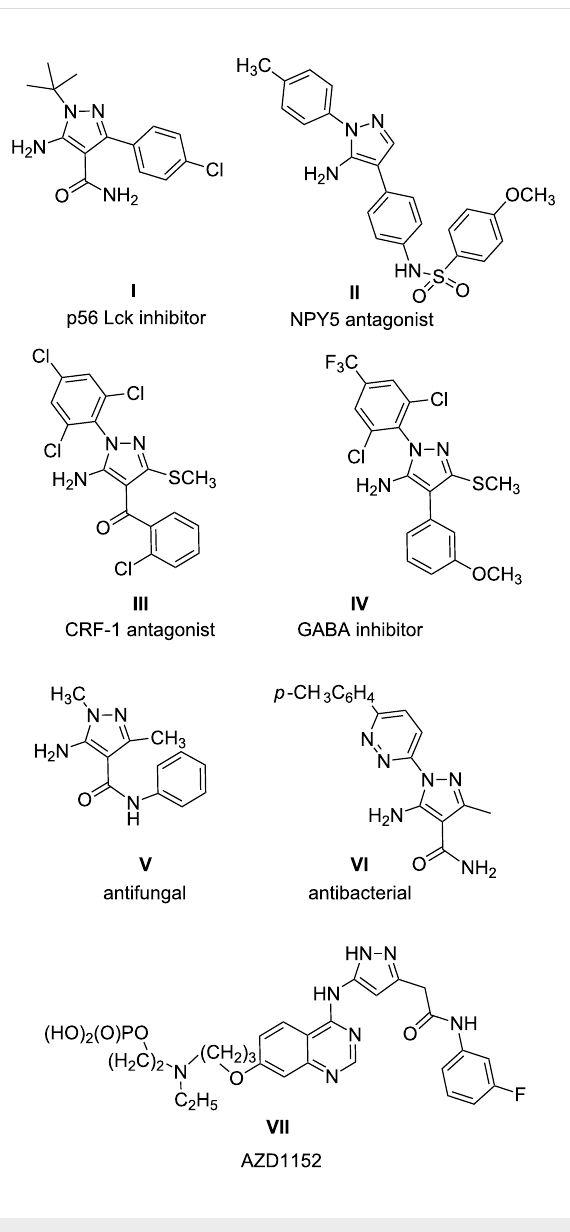
Figure 1: Pharmacologically active 5-aminopyrazoles.